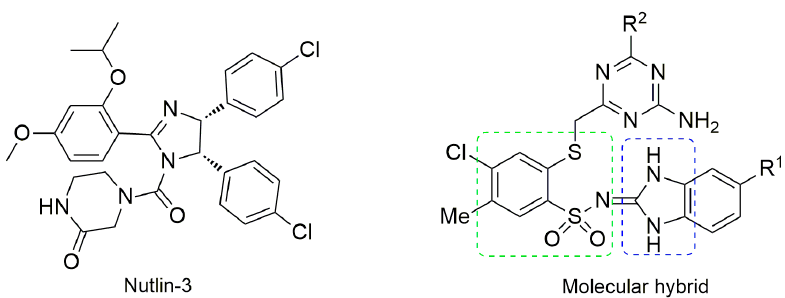
Figure 1. Structures of Nutlin-3a and a molecular hybrid including the 2-mercaptobenzenosulfonamide fragment and imidazoline ring. The green dotted frame indicates the 2-mercaptobenzenosulfonamide fragment and blue dotted frame shows the imidazoline ring.